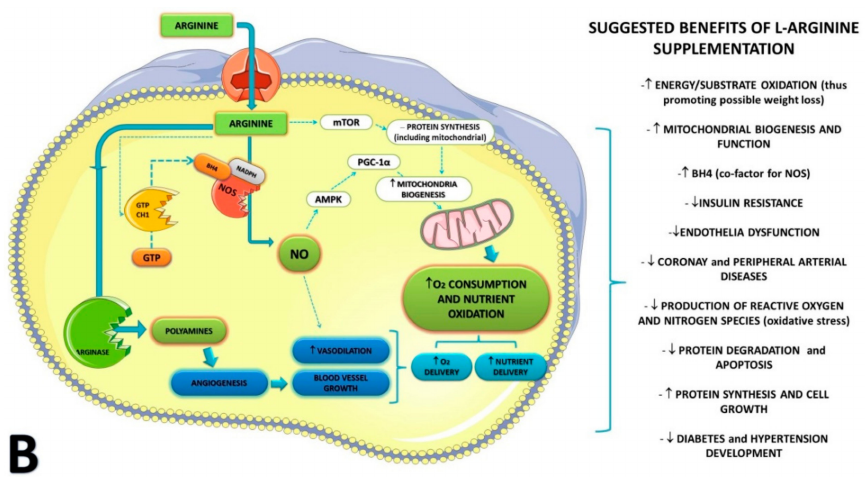
Figure 1. Mechanisms for lowering nitric oxide (NO) availability in cardiovascular and metabolic disorders ( A ). Increased angiotensin II (AngII) levels, asymmetric dimethylarginine (ADMA), and